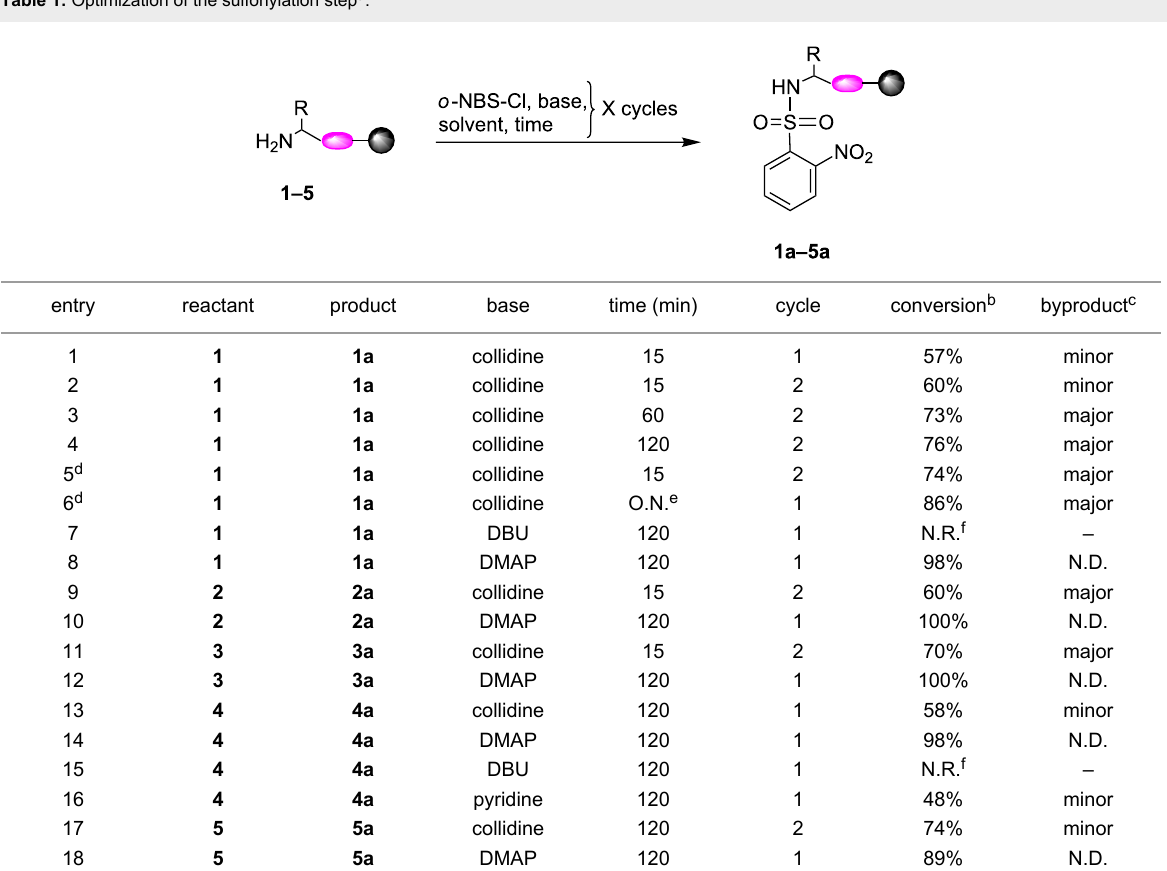
Table 1: Optimization of the sulfonylation step a